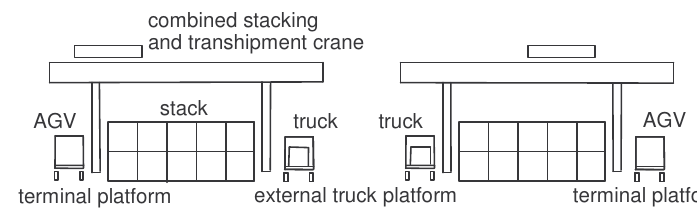
Figure 2. Profile of a duo truck service